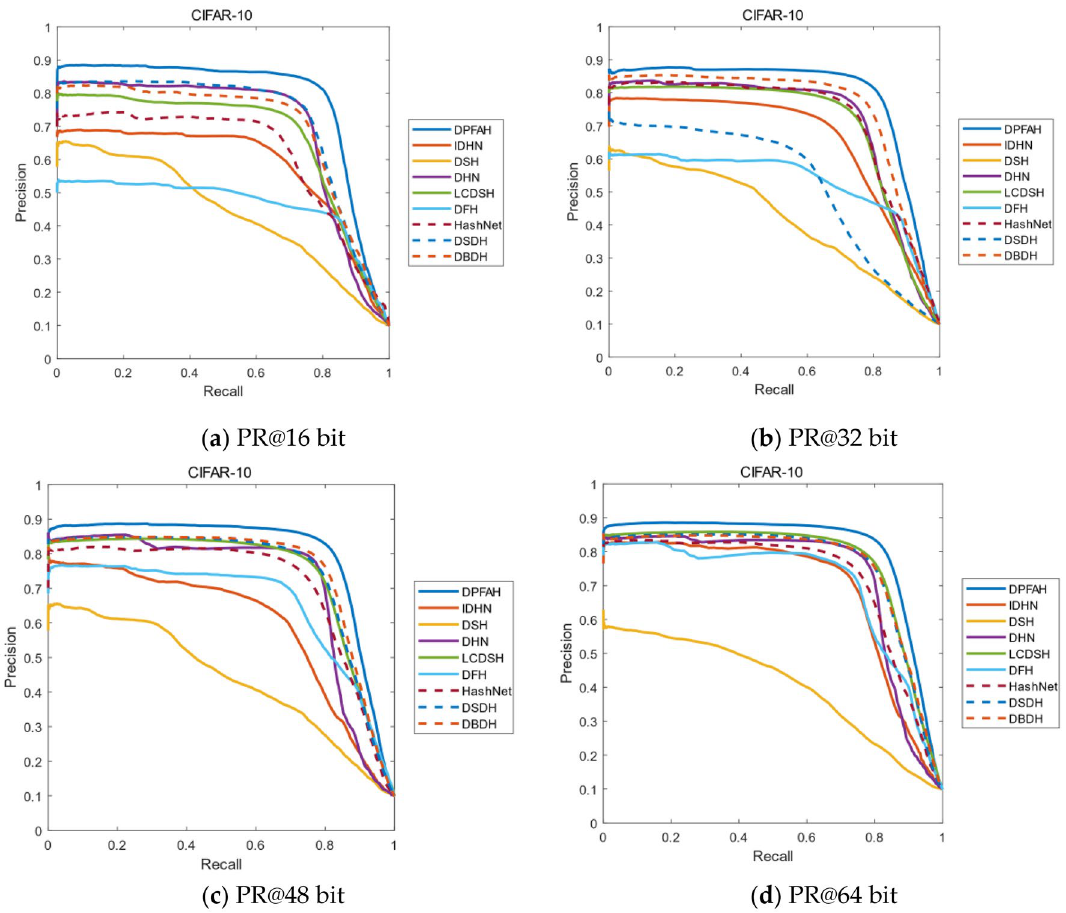
Figure 8. ( a–d ) The PR curves on CIFAR-10 of all methods with different bits. (Created by “matlab R2019a” url: https:// ww2. mathw orks. cn/ produ cts/ matlab.